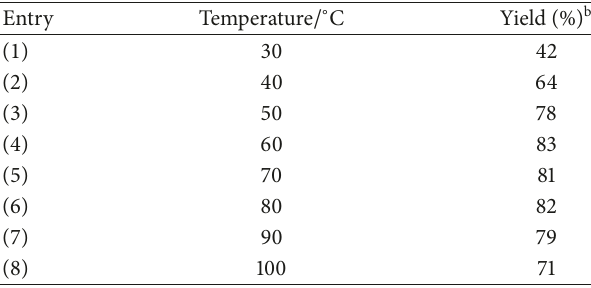
Table 2: Effects of reaction temperature on the